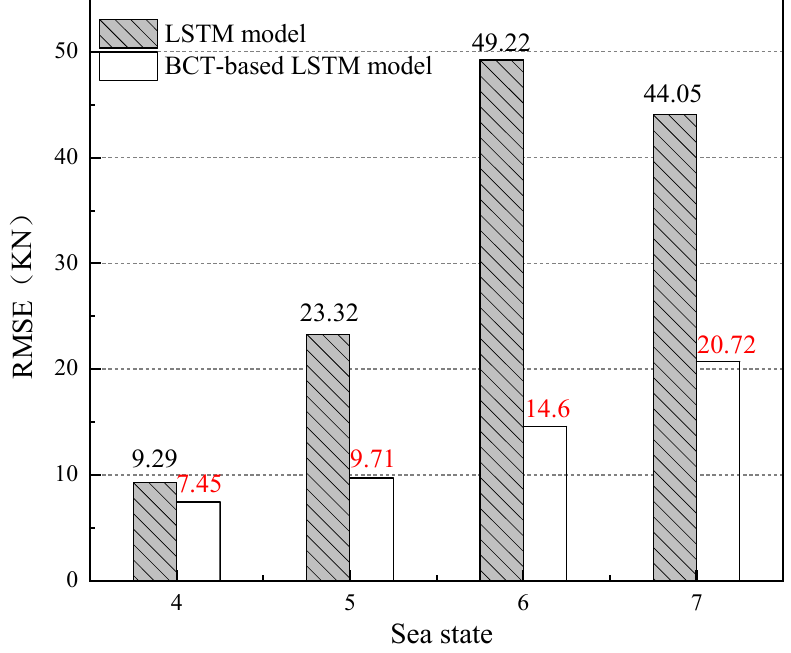
Figure 13. The comparison of RMSE of prediction results.